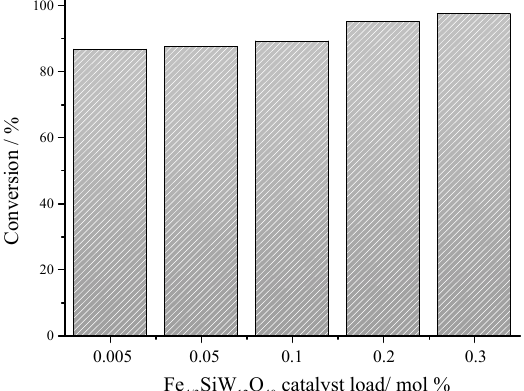
(variable); temperature (298 K); Fe 4/3 SiW 12 O 40 catalyst (0.30 mol%); volume (10 mL); and reaction time (1 h). time (1 h).